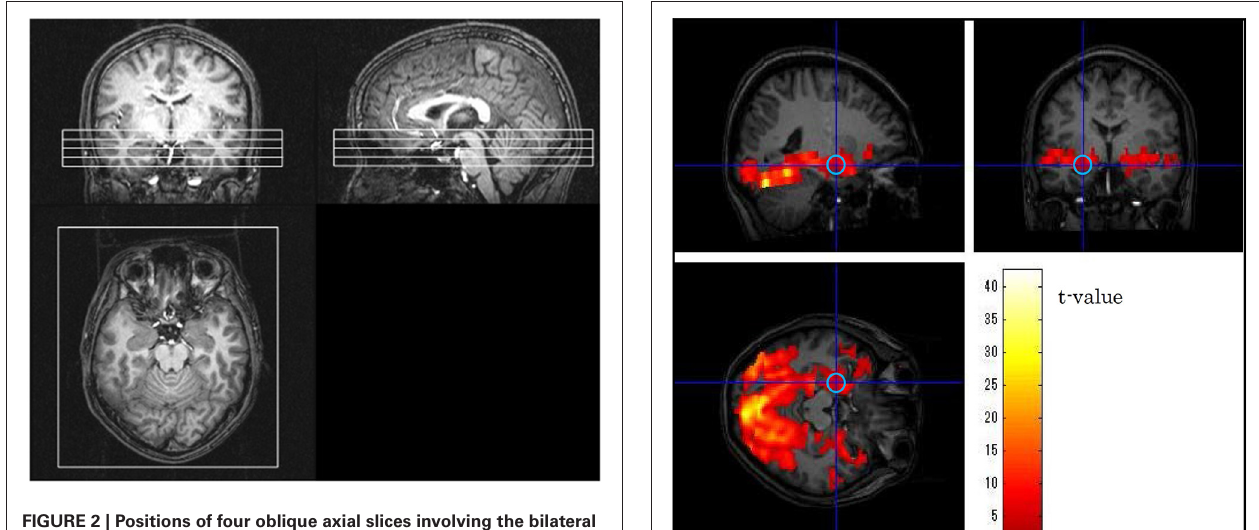
FIGURE 2 | Positions of four oblique axial slices involving the bilateral amygdalae, the bilateral anterior VLPFCs (BA47) and the primary visual cortex . The slice position was decided by aligning the top slice with the anterior commissure and the posterior commissure (AC-PC) line.